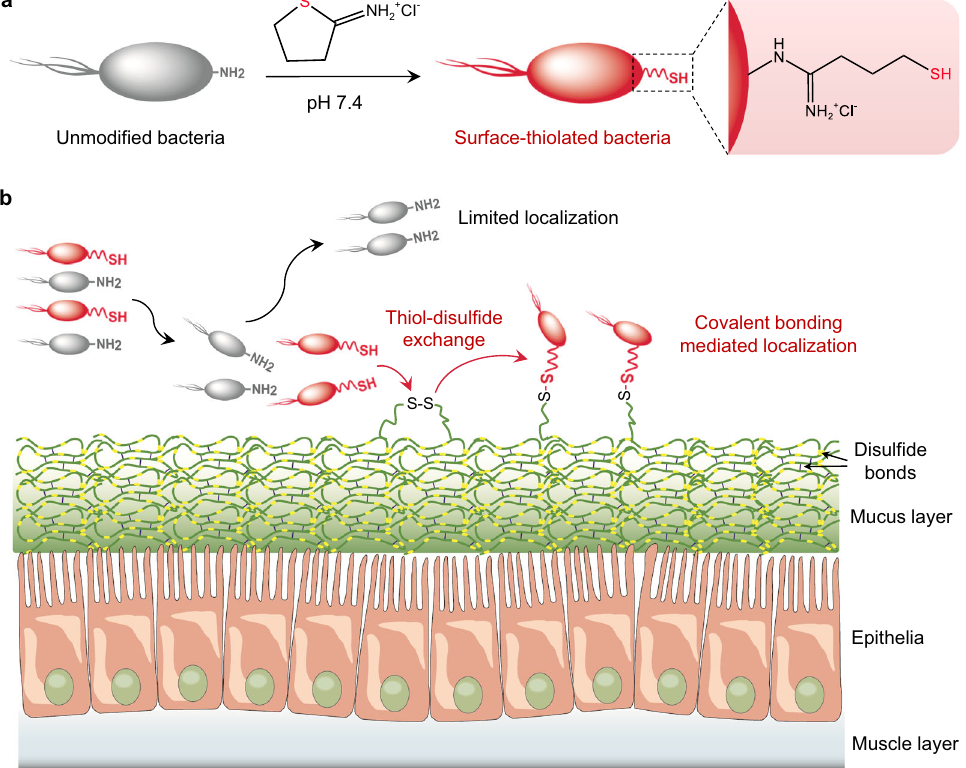
Fig. 1 | Schematic illustration of chemical reaction-mediated covalent locali- zationofbacteria.a Preparationofsurface-thiolatedbacteriabyasimpleone-step imidoester reaction under cytocompatible conditions. b Bonding of chemically